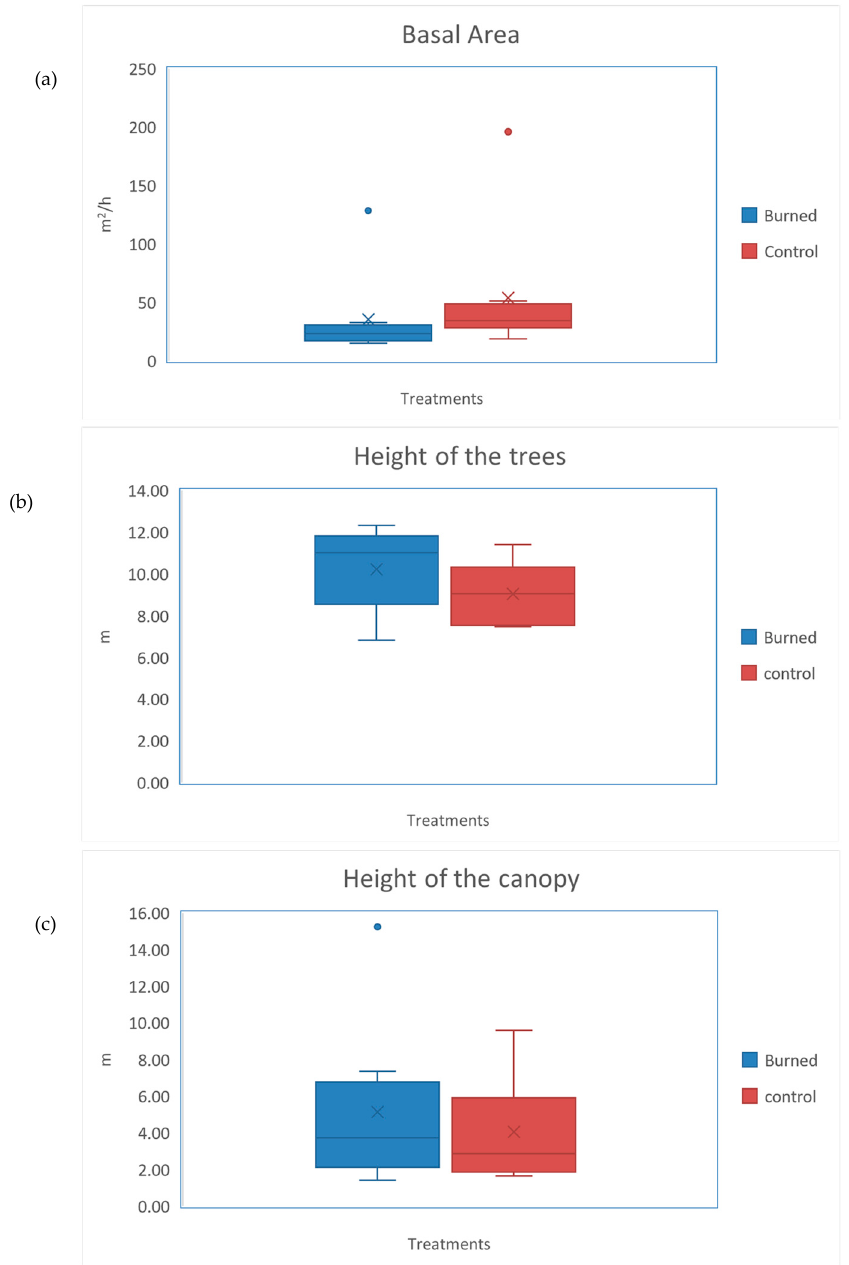
Figure 2. ( a ) Box plots of basal area values for the 8 plots of the burned and control treatments; ( b ) average height of the trees; ( c ) canopy height.